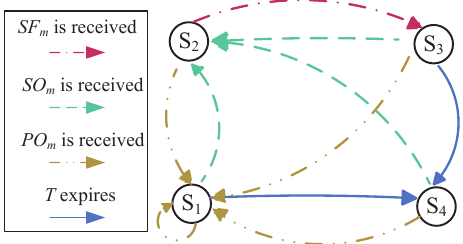
Figure 2. State transition